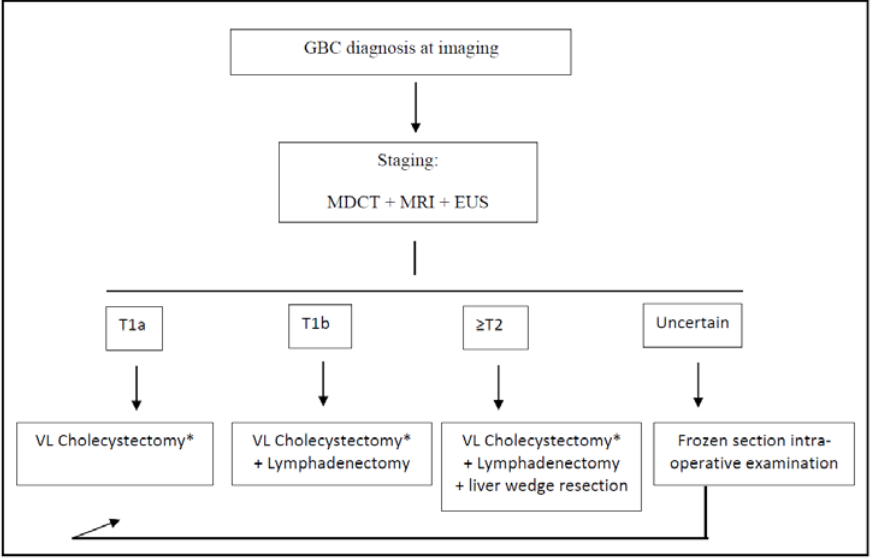
Figure 1. Treatment algorithm for the post-imaging diagnosis of GBC. * Frozen section intra-operative examination of cystic duct margin is always performed during cholecystectomy; if positive, common bile duct resection is performed. GBC: gallbladder cancer; VL: video-laparoscopic; MDCT: multi-detector computed tomography; MRI: magnetic resonance imaging; and EUS: endoscopic ultrasounds.